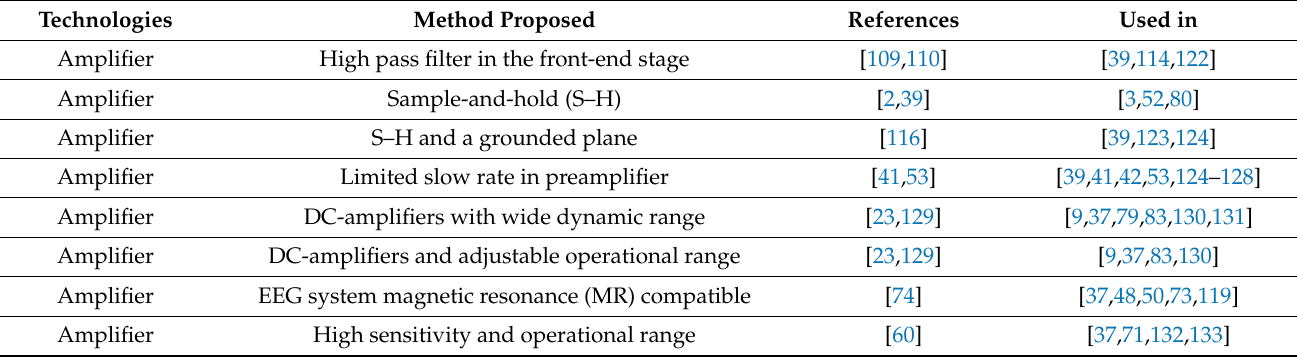
Table 2. An overview of electronic upgrades in an EEG